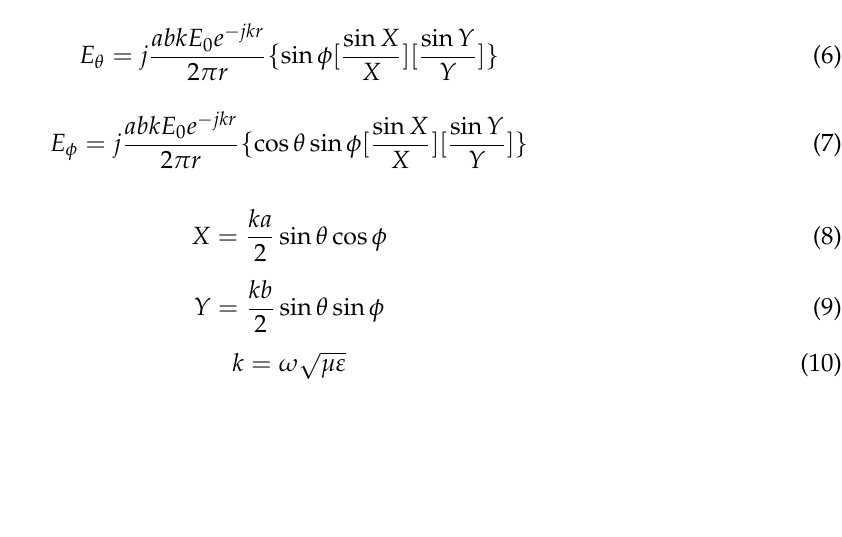
Figure 5. This is the geometric layout of the MOA. The antenna is printed on the FR-4 substrate, whose overall dimension is 177.75 × 91.5 × 2 mm 3 with a thickness of 2.0 mm, loss tangent of 0.02 and fractional permittivity of 4.4.